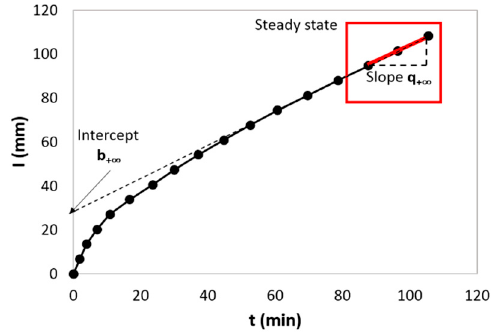
Figure 3. Example of the cumulative infiltration curve I(t) from site A. The slope and intercept of the steady state model are also represented.